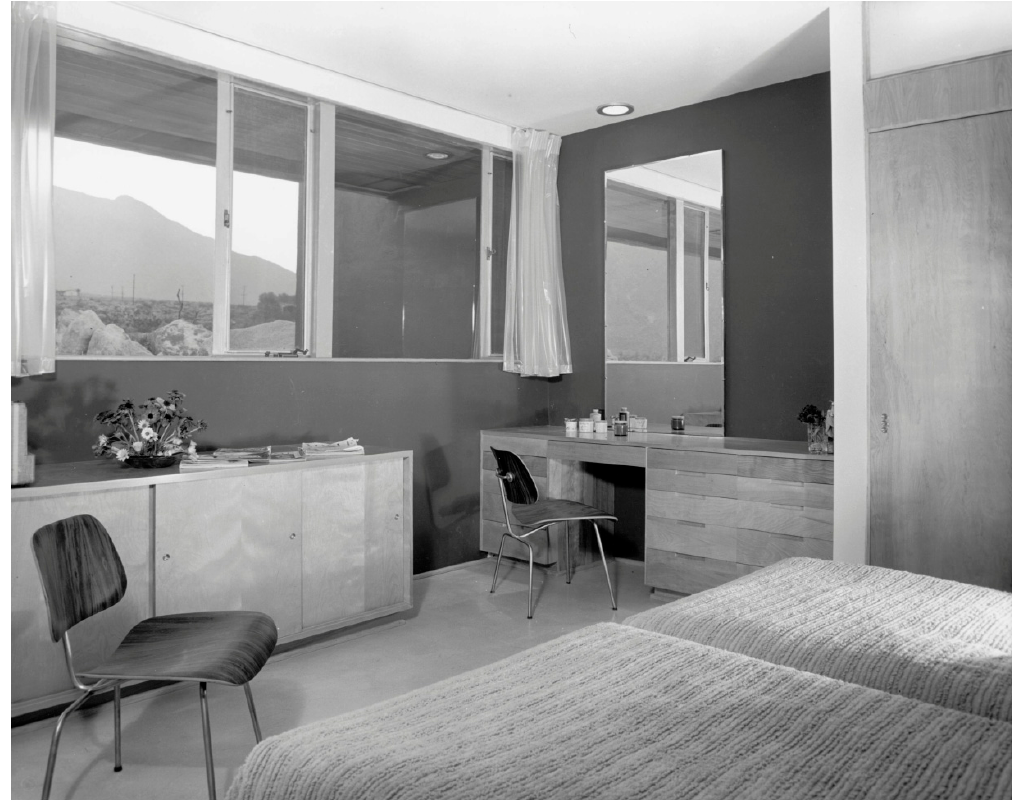
Figure 8. Richard Neutra, Kaufmann Desert House, Palm Springs, 1946–1947. Maids’ Room #2. (Photo by Julius Shulman, job 093-46, © J. Paul Getty Trust. Getty Research Institute, Los Angeles, 2004.R.10).